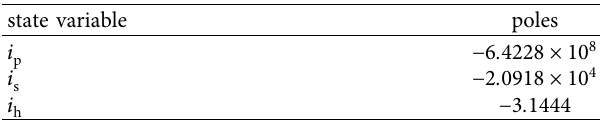
for the two state red